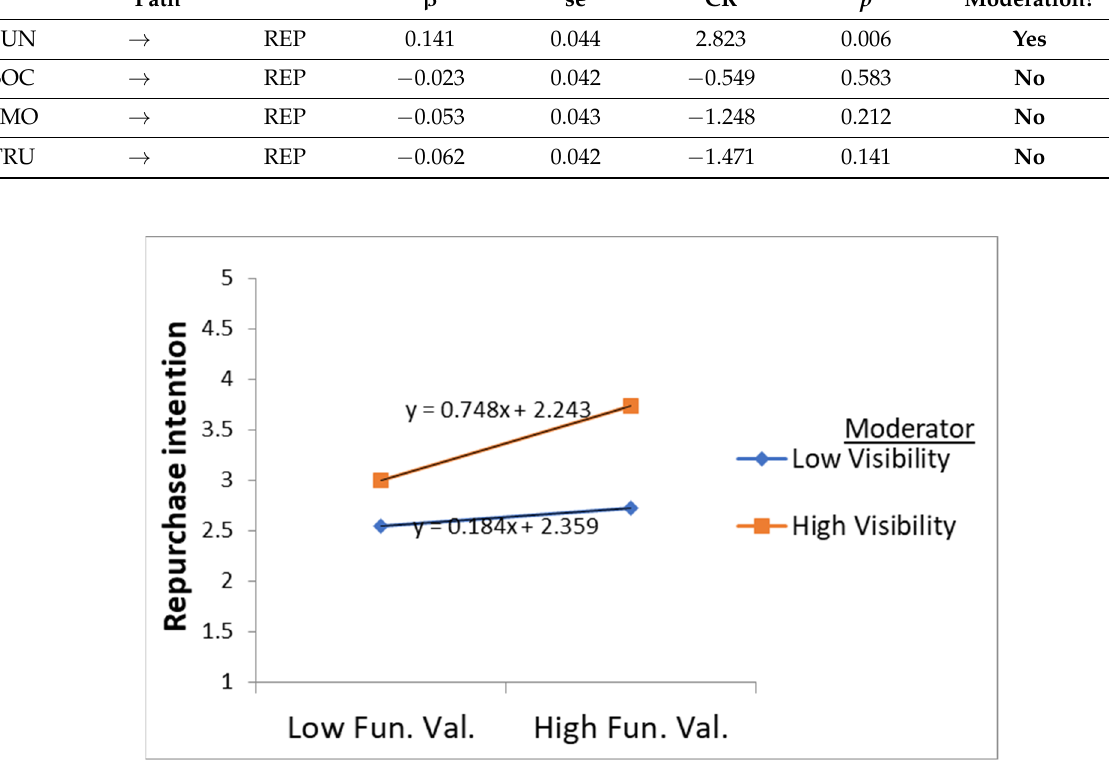
Figure 3. The moderating role of Visibility on the association between Functional Value and Repur- chase Intention.